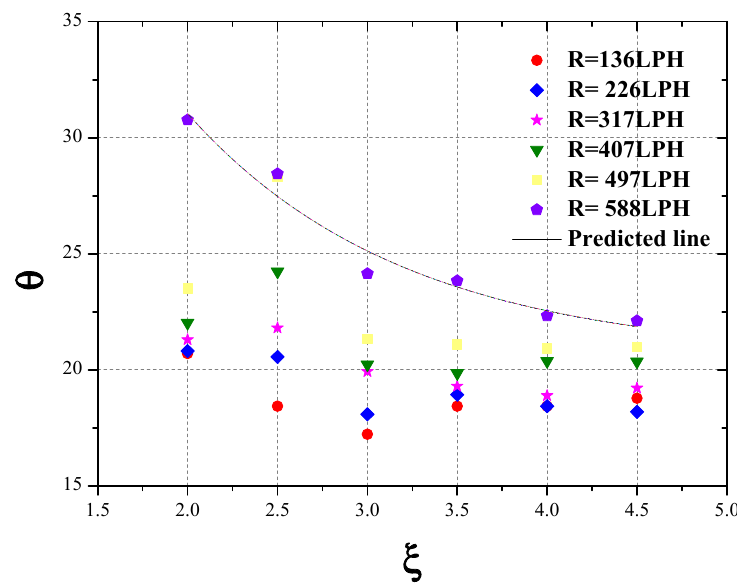
Figure 10. Dimensionless maximum oscillation distance of bubbly flow at the various aspect ratios.